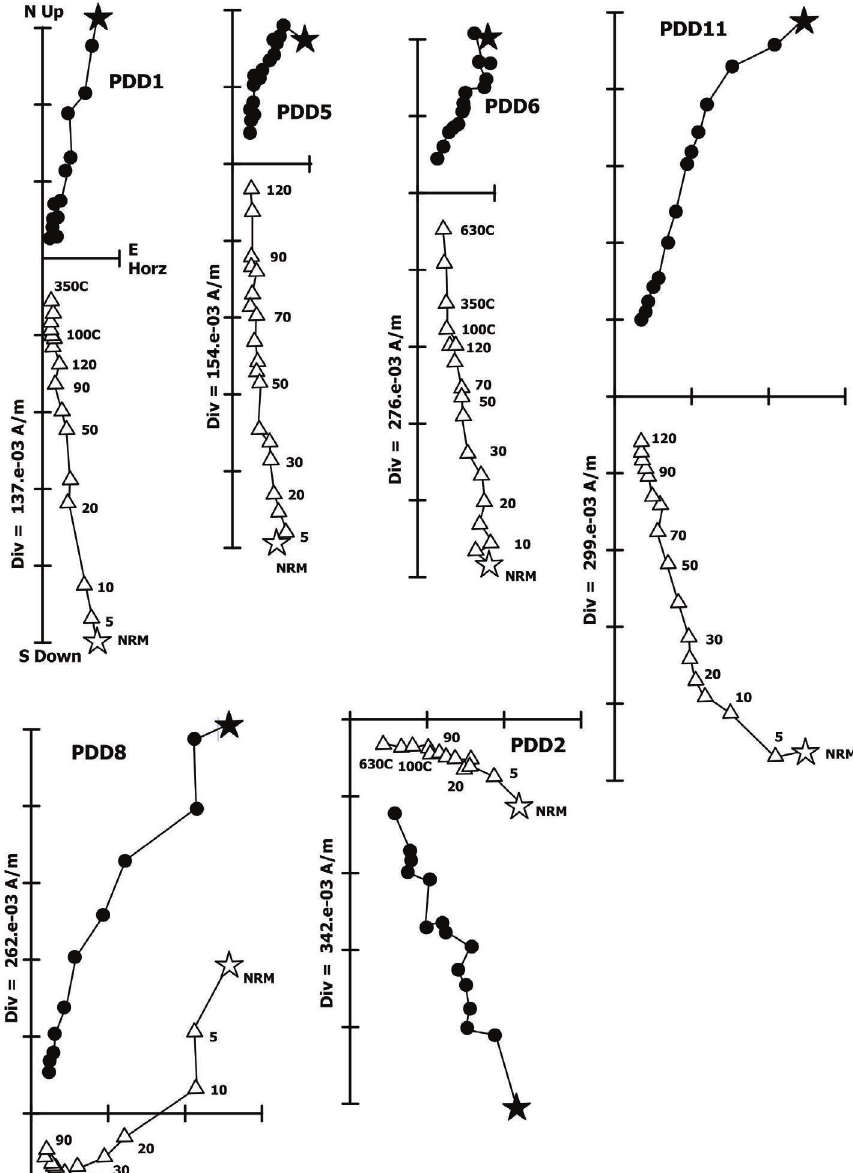
Figure 11: Orthogonal demagnetization diagrams representing the typical AF and TH demagnetization behavior [Zijderveld 1967]. Solid symbols represent the projection onto the horizontal plane, open symbols onto the vertical. The demagnetization steps are given in mT and temperature (T ◦ C). Magnetization (in A/m) is shown along one axis for each sample; each division equals indicated intensity. A few samples contained additional low coercivity viscous remanent magnetization (VRM) components that were readily randomized by 20